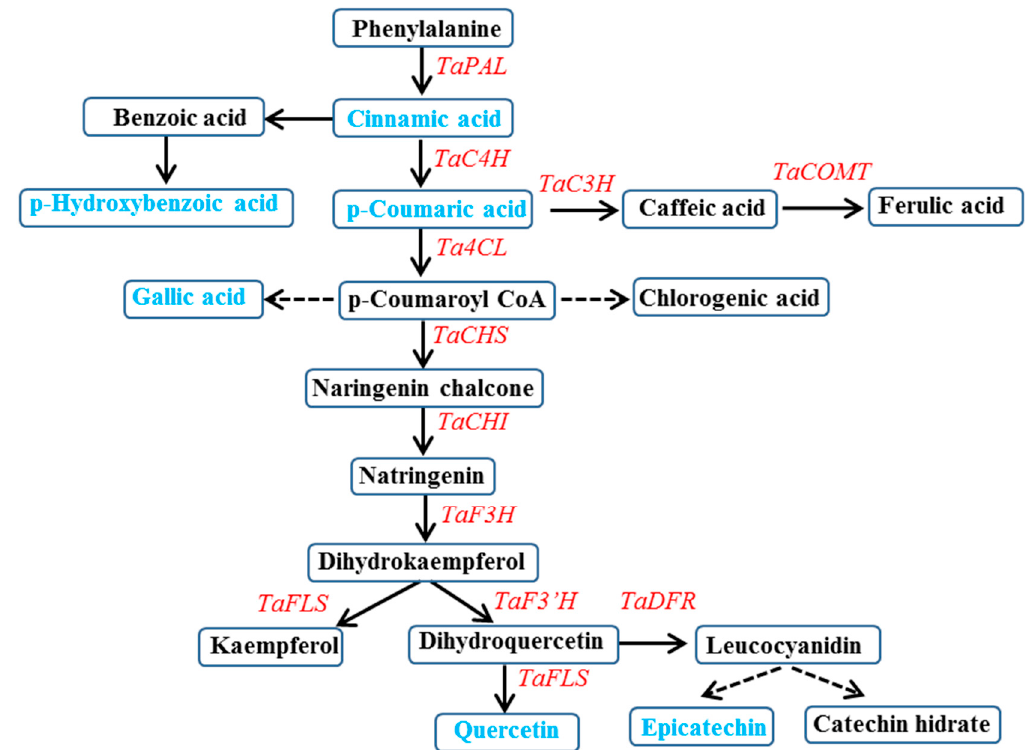
Figure 1. Proposed phenylpropanoid and flavonoid biosynthetic pathway in wheat sprouts. Blue color denotes the phenylpropanoids and flavonoids assessed in this study via HPLC analysis. Red color indicates the enzymes whose gene expression was assessed via qRT-PCR. PAL, phenylalanine ammonia-lyase; C4H, cinnamate 4-hydroxylase; C3H, 4-hydroxycinnamate 3-hydroxylase; COMT, caffeic acid 3-O-methyltransferase; 4CL, 4-coumaroyl CoA ligase; CHS, chalcone synthase; CHI, chalcone isomerase; F3H, flavanone 3-hydroxylase; F3 ′ H, flavonoid 3 ′ -hydroxylase; FLS, flavonol synthase; DFR, dihydroflavonol-4 reductase; 3GT, flavonoid 3-o-glucosyltransferase.